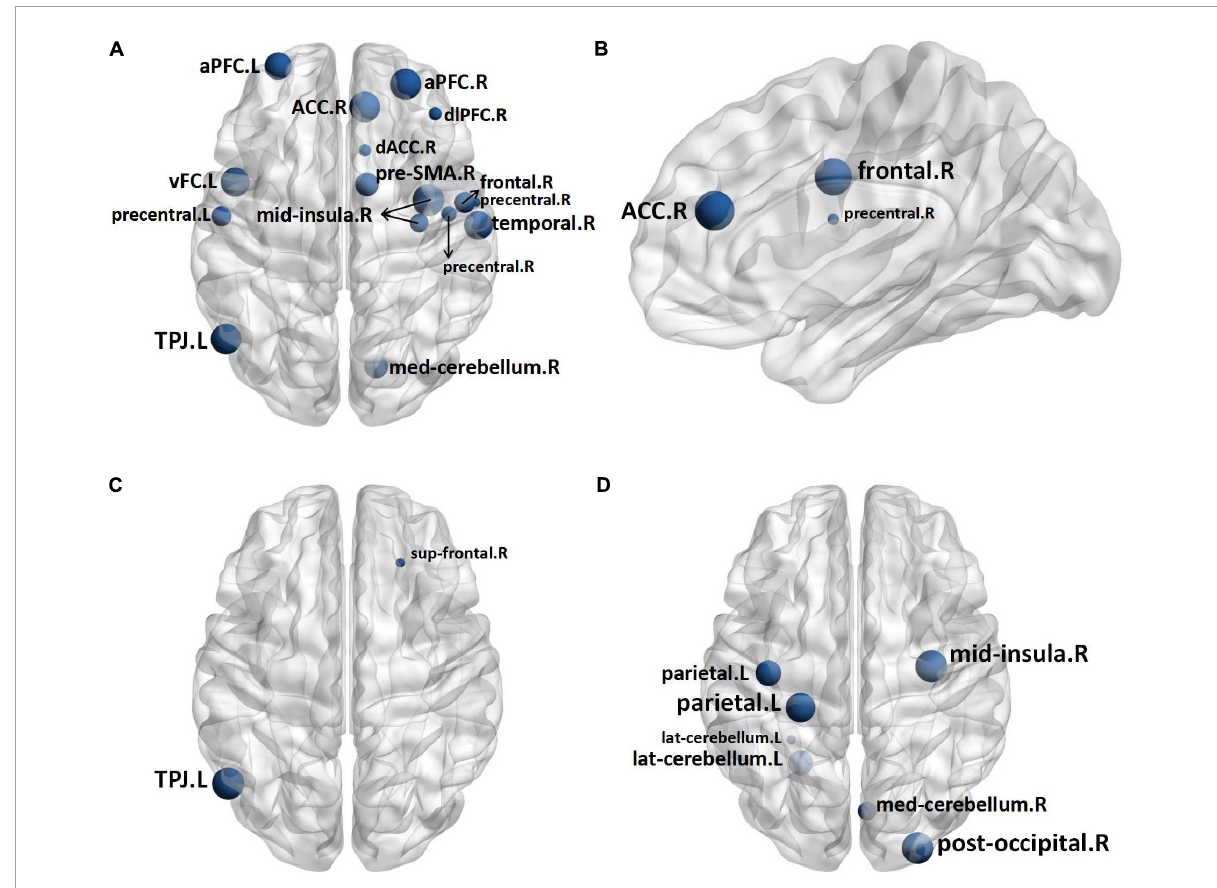
FIGURE4 In comparison to the Control Group, the nodes in the B Group with decreased nodal clustering coefficient (A) and nodal local efficiency (B) , and the nodes in the 1 h Group with decreased nodal clustering coefficient (C) . In comparison to Group A, the nodes in the B Group have a lower nodal clustering coefficient (D) . The size of the nodes represents the level of significance. Sup frontal, superior frontal gyrus; TPJ, temporo-parietal junction area; ACC, anterior cingulate cortex; aPFC, anterior prefrontal cortex; dACC, dorsal anterior cingulate cortex; vFC, ventral frontal cortex; mid insula, mid-insula; pre-SMA, presupplementary motor area; precentral, precentral gyrus; temporal, temporal lobe; med cerebellum, median cerebellum; parietal, parietal gyrus; post occipital, posterior occipital gyrus; lat cerebellum, lateral